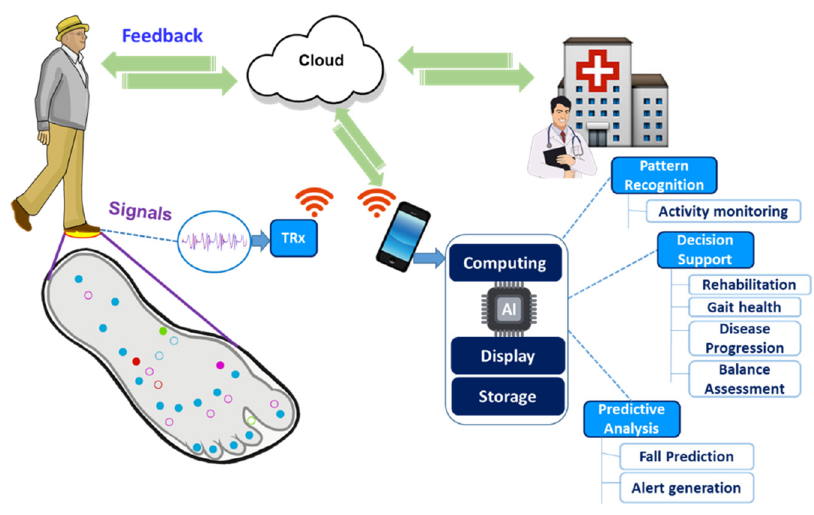
Figure 12. An Intelligent biofeedback system for older adults.